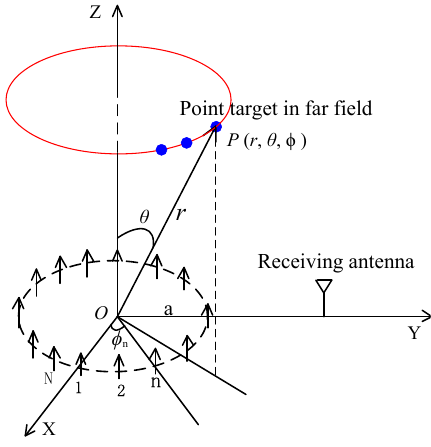
Figure 2. Coordinate frame of electromagnetic (EM) vortex